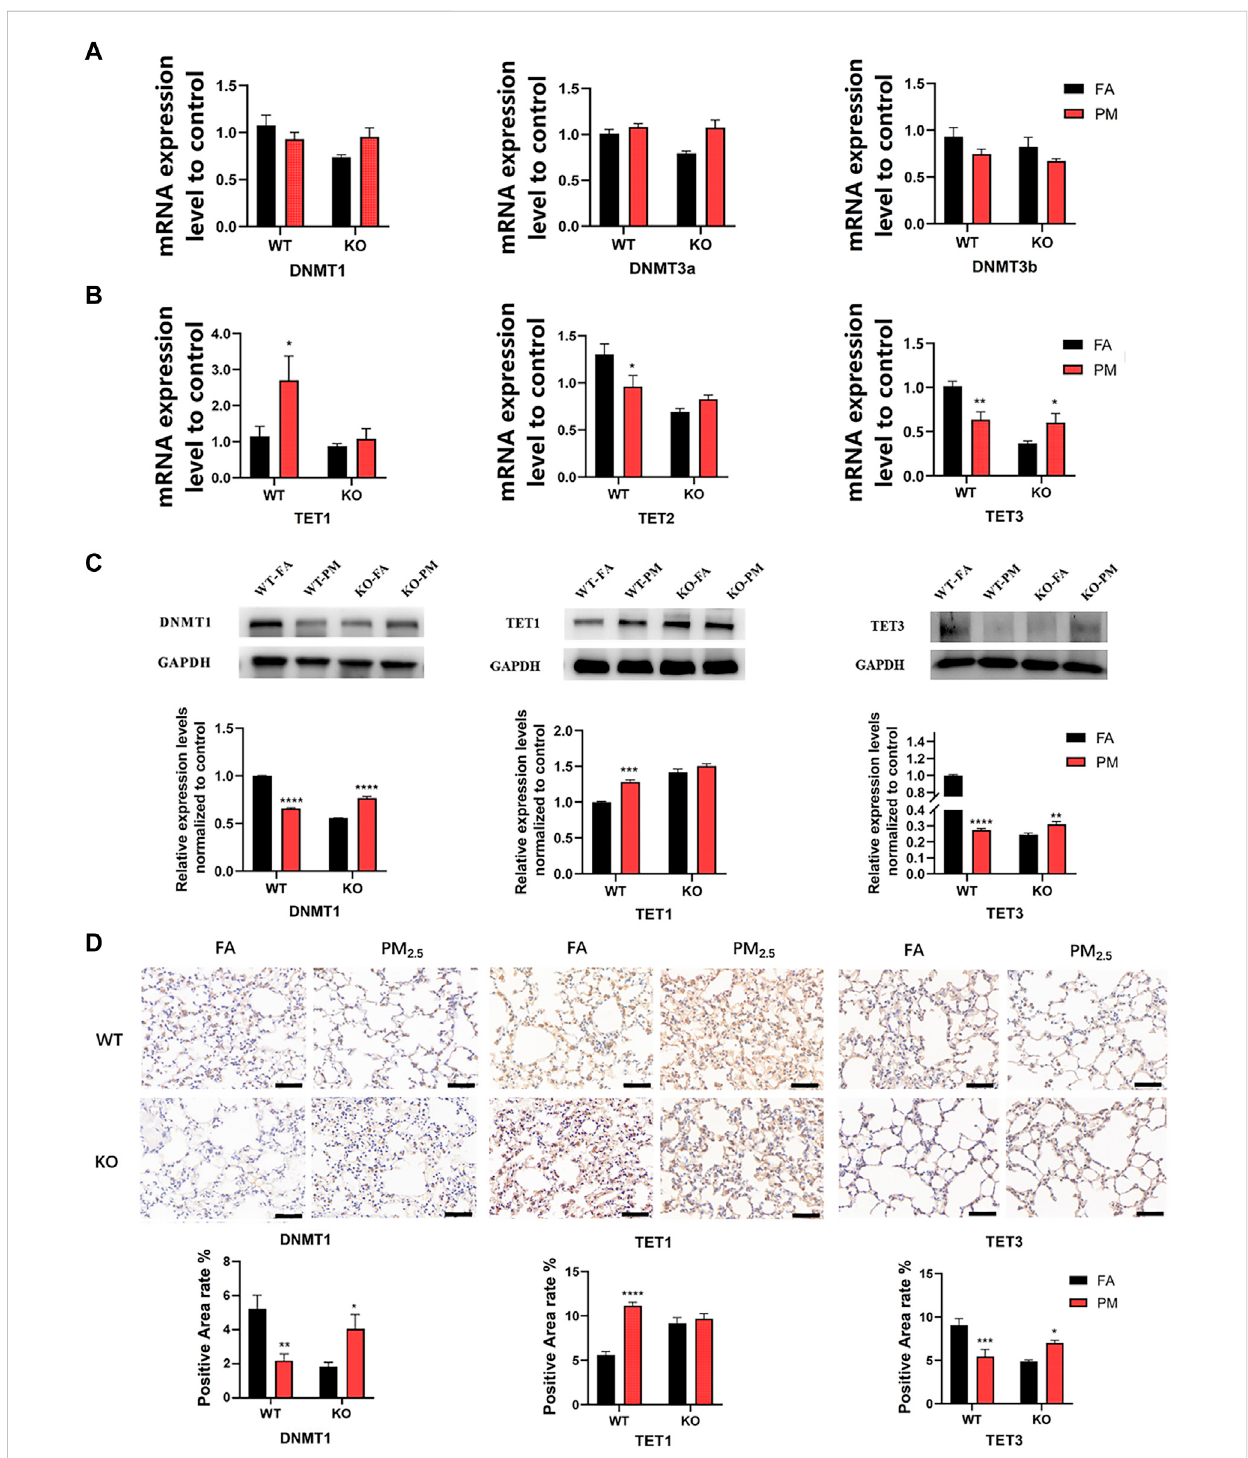
Expression of DNA methylation-related enzymes in four groups. (A) The DNA methyltransferase mRNA expression. n = 3 per group. (B) The DNA demethyltransferase mRNA expression levels. n = 3 per group. (C) WB analysis of protein levels of DNMT1, TET1, and TET3 expression. n = 3 in each group. (D) Immunohistochemical analysis of the positive area levels of DNMT1, TET1, and TET3. FA, fi ltered air; PM, fi ne particulate matter; WT, wild-type mice; KO, Nrf2 − / − mice. Scale bars are 50 μ m, n = 3 per group. Error bars represent mean ± SEM, * p < 0.05,** p < 0.01,*** p < 0.001,**** p <